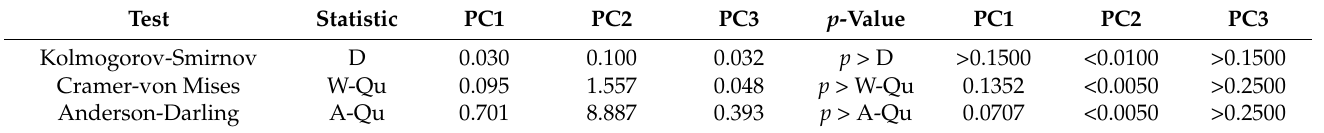
Table 2. Normality tests of the PCs.